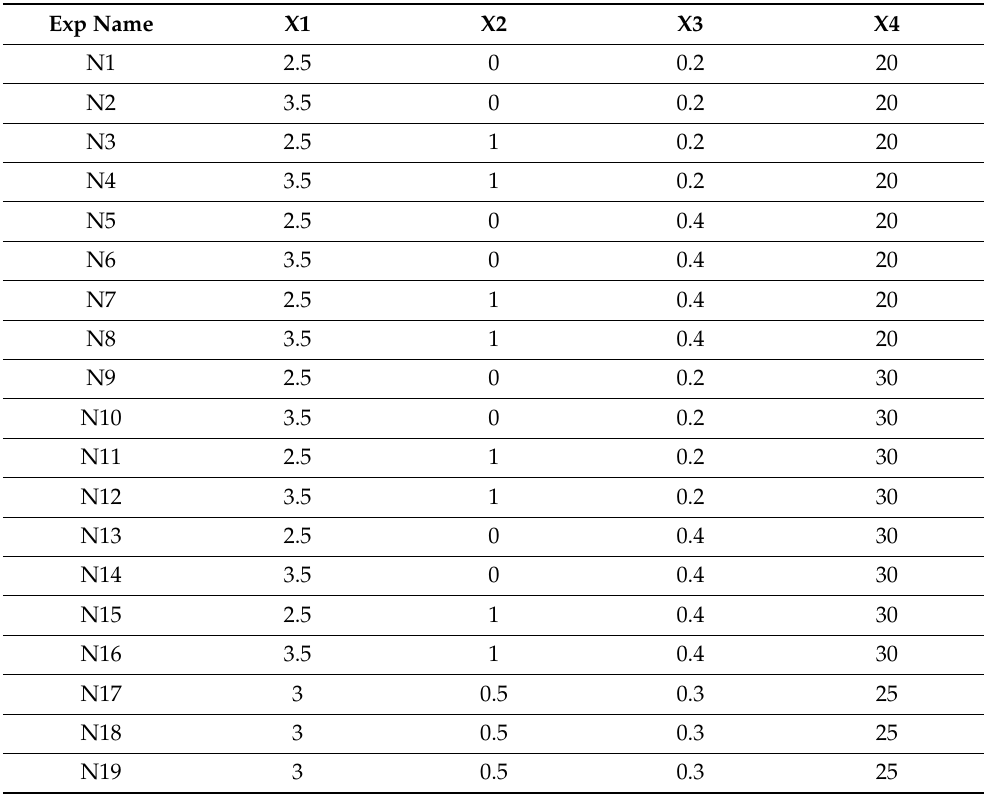
Table 11. Experimental design